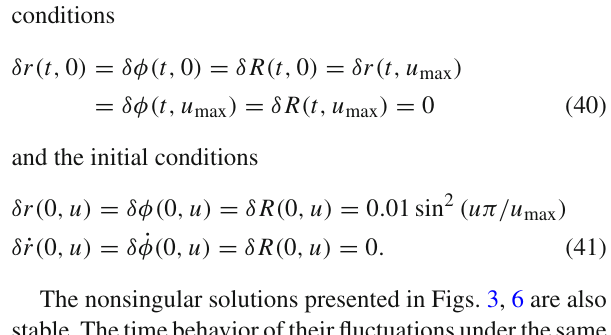
nonzero Hubble parameter H and (as confirmed by calcula- tions) is absent if H =